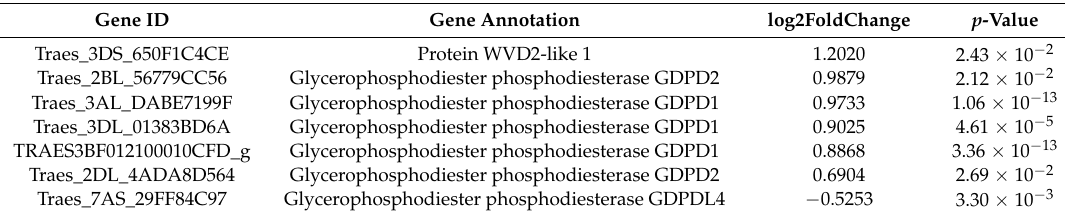
Table 1. List of selected genes for glycerophosphodiester phosphodiesterase activity that were differentially expressed in B36 vs.